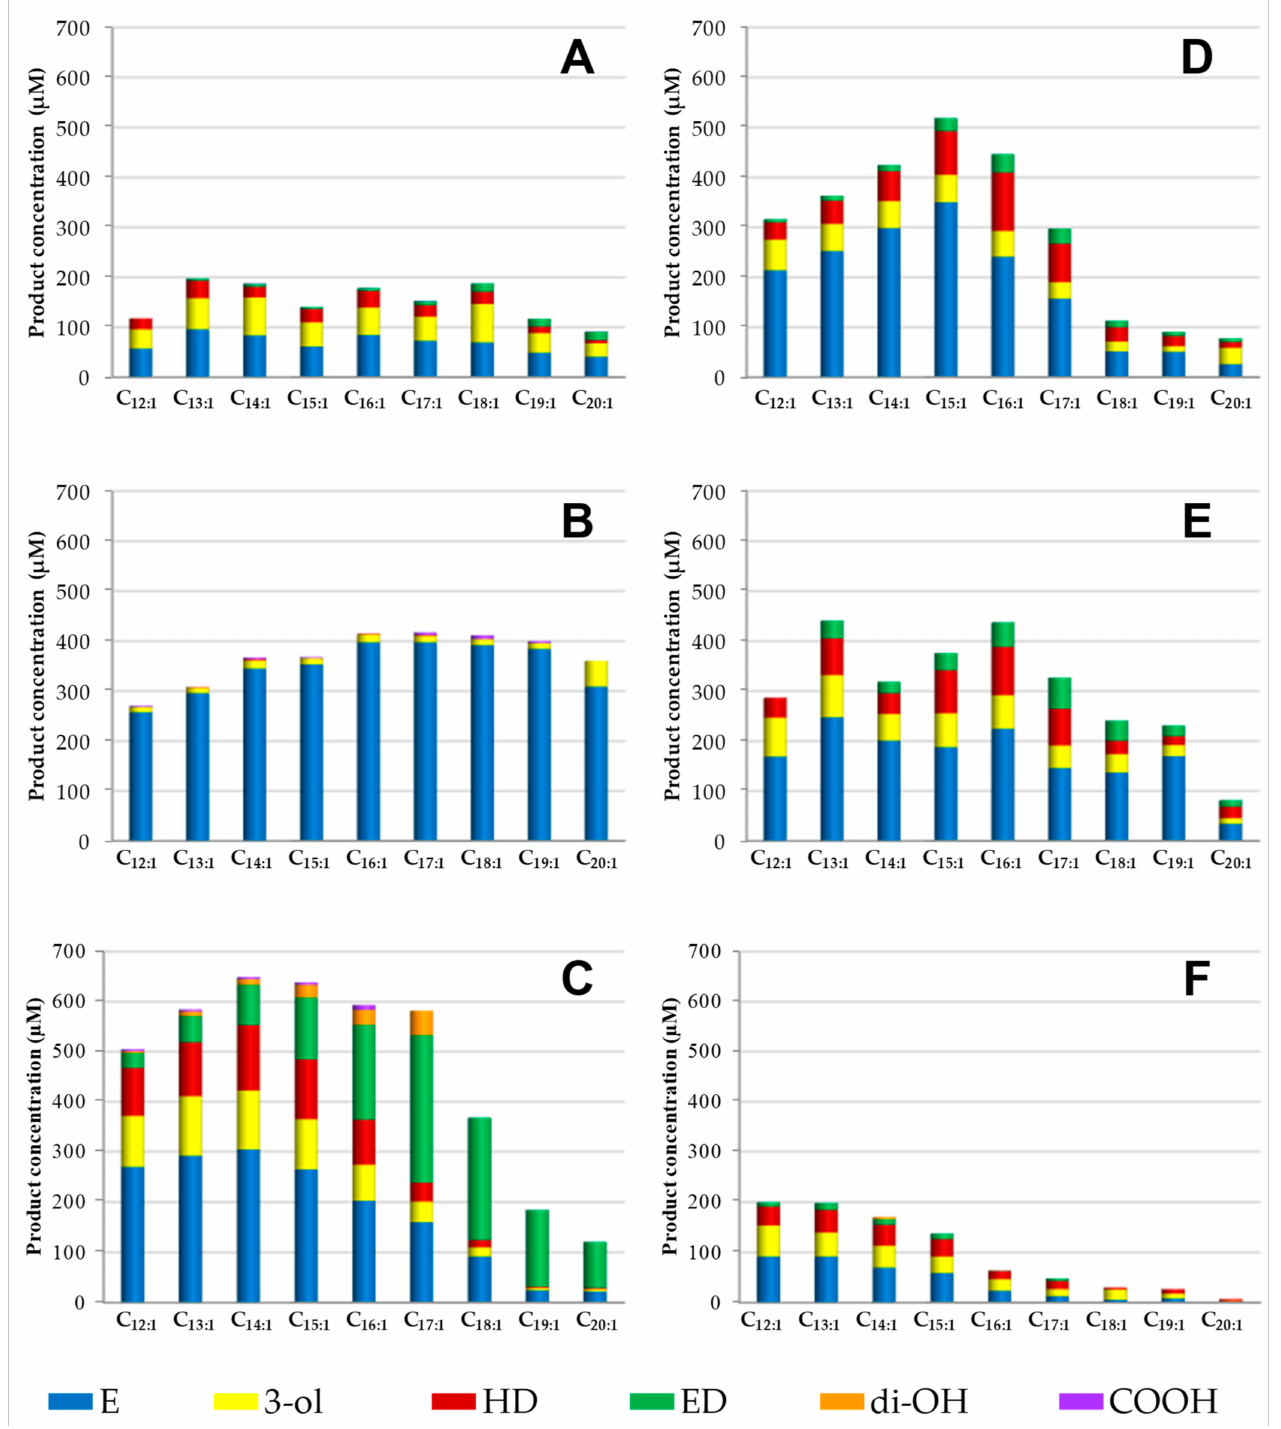
Figure 2. Enzymatic reactions of 1 mM long-chain terminal alkenes (C 12:1 to C 20:1 ) with 3 µ M of UPOs. Aae UPO ( A ); Mro UPO ( B ); r Cci UPO ( C ); Cgl UPO ( D ); r Hin UPO ( E ); r Dca UPO ( F ) within 2 h reaction and with 3 mM H 2 O 2 (in 60% acetone). Products: 1,2-epoxy-alkanes (E, blue), 3-hydroxy-alkenes (3-ol, yellow), monohydroxylated alkenes (HD, red), monohydroxylated epoxy-alkanes (ED, green), dihydroxy alkenes (di-OH, orange), and carboxylic acids (COOH,